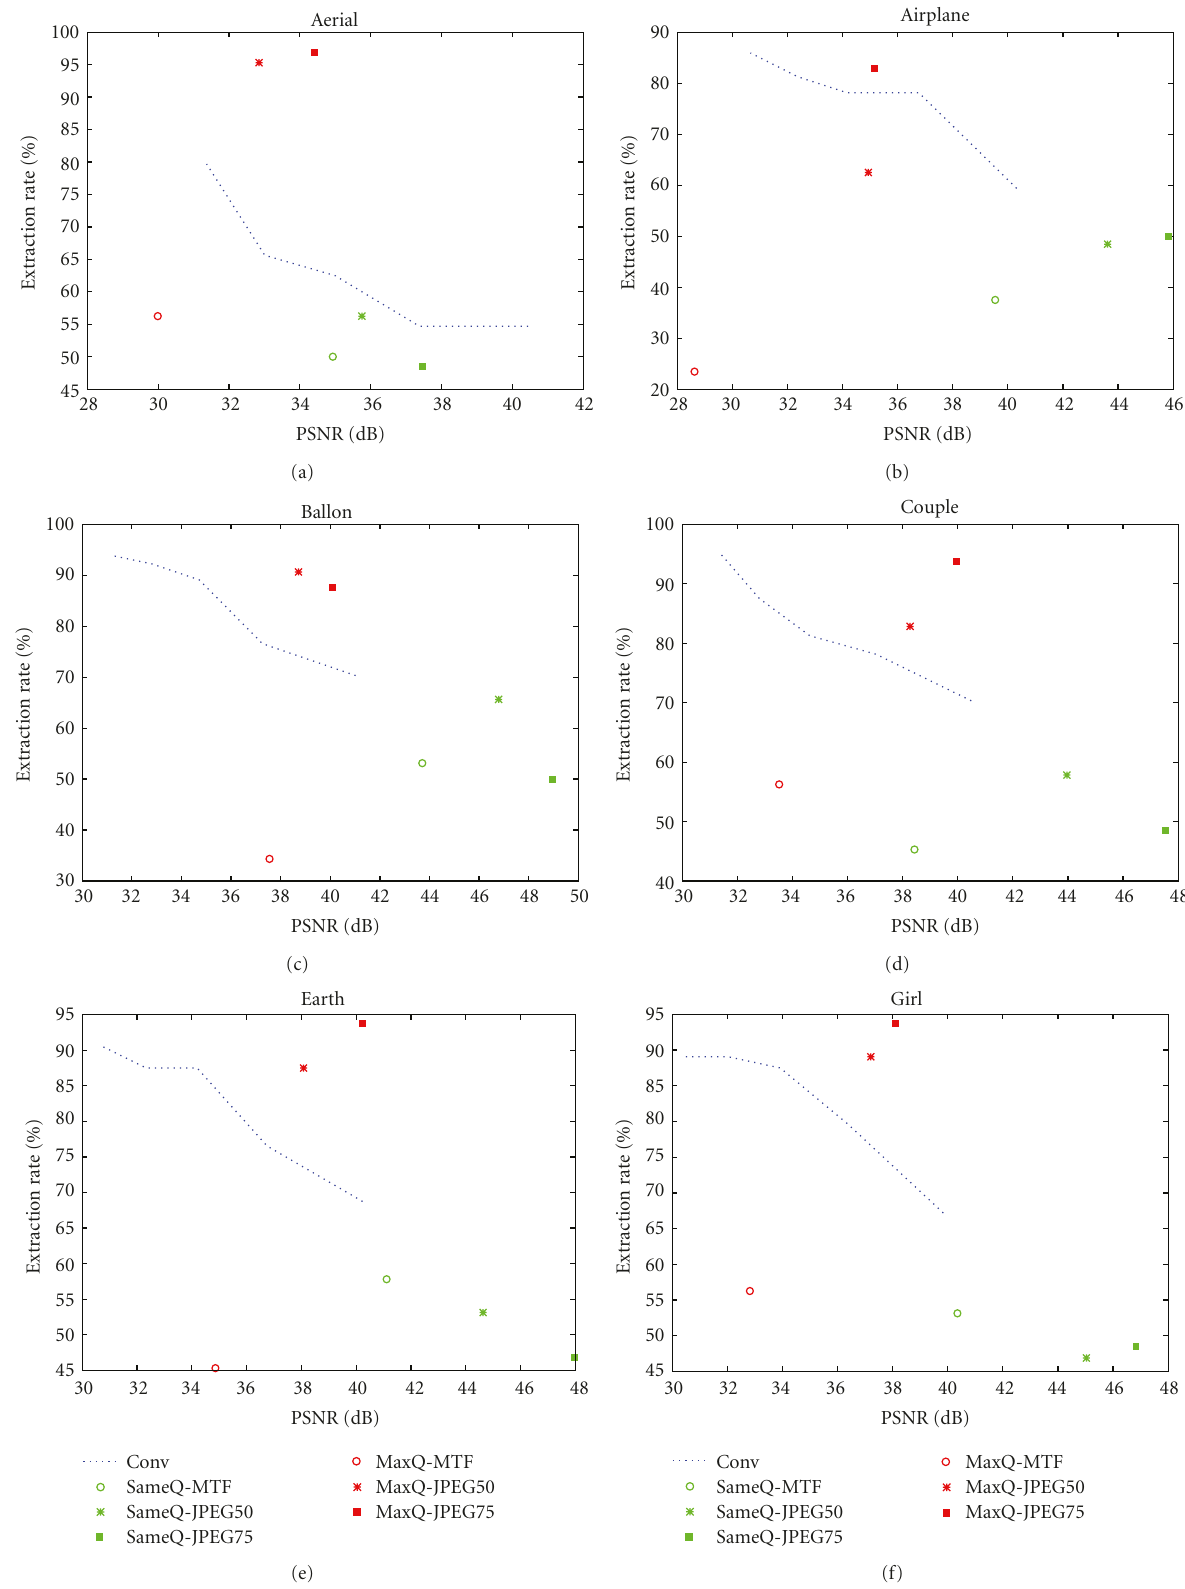
Figure 16: Comparison in the robustness against JPEG compression of quality 75%